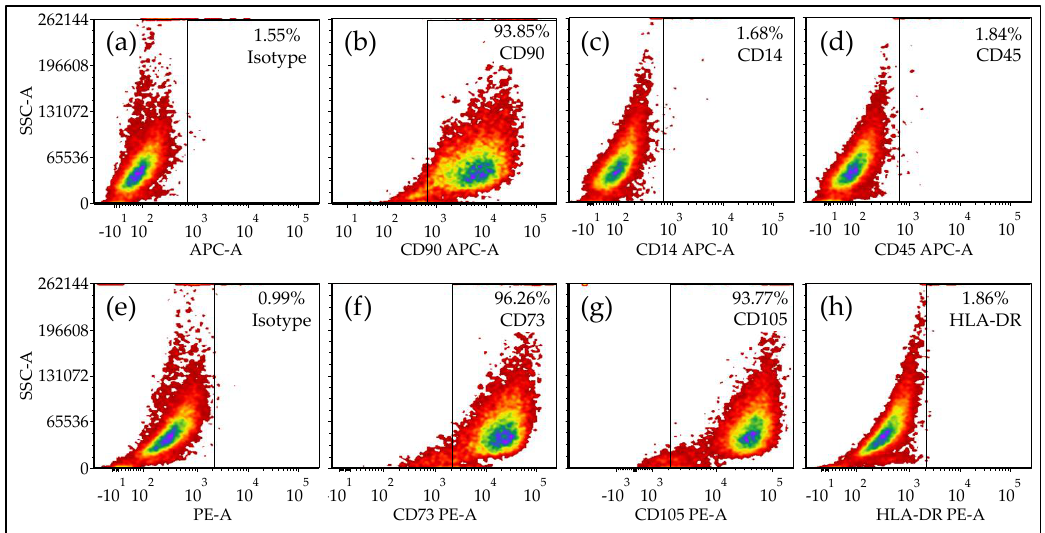
Figure 6. CD-marker expression in Ad-MSCs in passage 3. Ad-MSCs were stained for CD markers in passage 3. The analysis was done by flow cytometry as described [44] and is presented as scatter blot. Representative images for: ( a ) Isotype control for APC (allophycocyanin) secondary antibody. Ad-MSCs stained for ( b ) CD90-APC, ( c ) CD14-APC, and ( d ) CD45-APC. ( e ) Isotype control for PE (phycoerythrin) secondary antibody. Ad-MSCs stained for ( f ) CD73-PE, ( g ) CD105-PE, and ( h ) HLA-DR-PE.